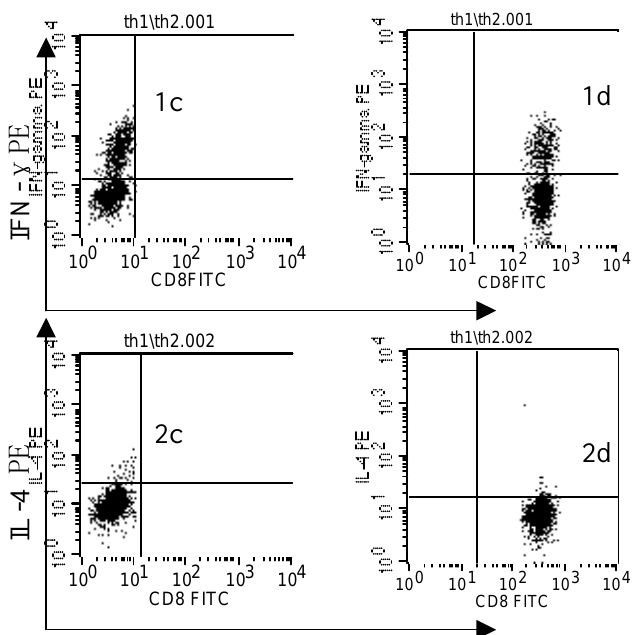
Figure 4 . Three-color flow cytometric analysis of type 1/type 2 immunity in blood from normal term pregnancy . 1c, Th1 cells. 2c, Th2 cells. 1d , Tc1 cells. 2d , Tc2 cells . Percentages of these cell